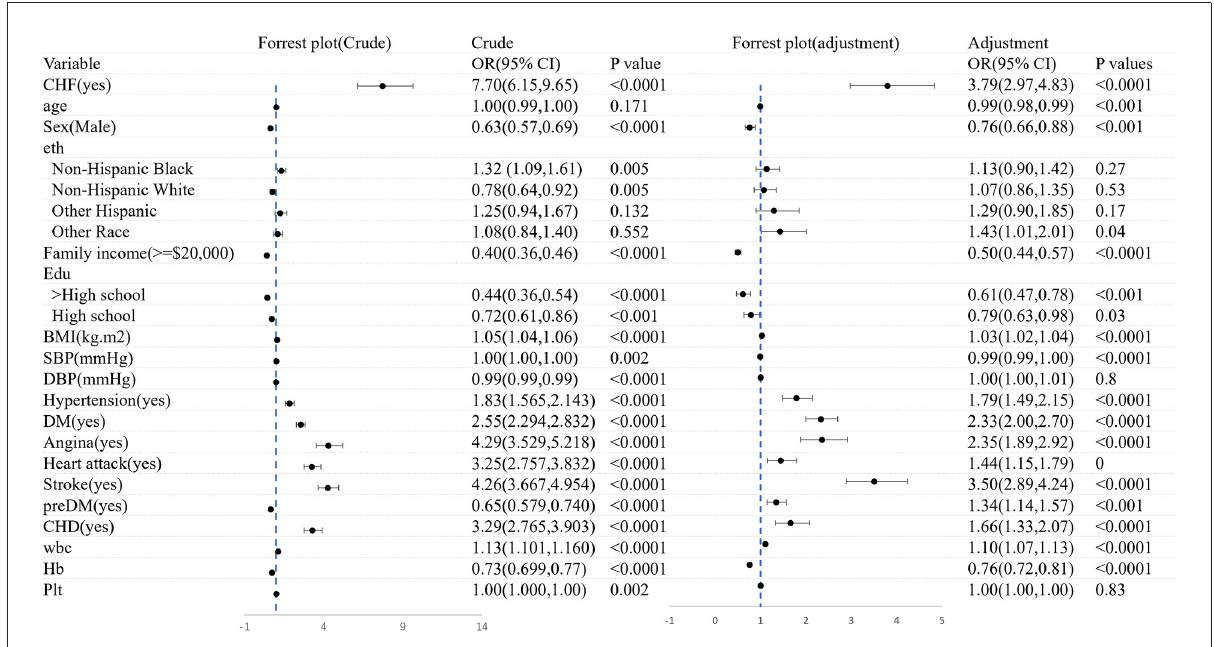
FIGURE5 The logistic regression analysis of frailty before and after adjustments for the